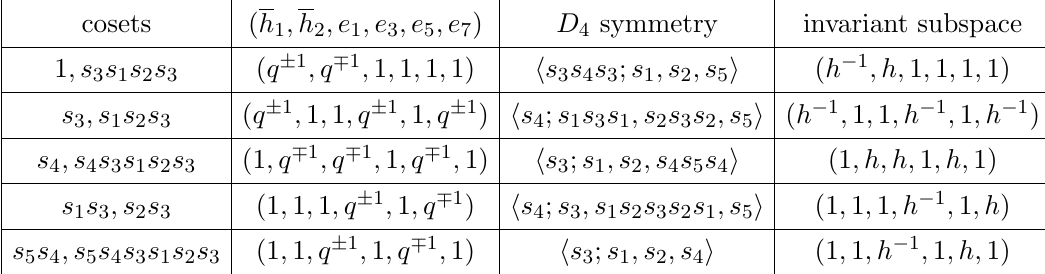
Table 3 . Di(cid:11)erent representative choices of the parameters for the (2 ; 2) model without rank deformations. The parameters ( h 1 ; h 2 ; e 1 ; e 3 ; e 5 ; e 7 ) are obtained by acting the 10 cosets of the D 5 Weyl group by the invariant D 4 Weyl group (where the upper/lower double-sign corresponds to